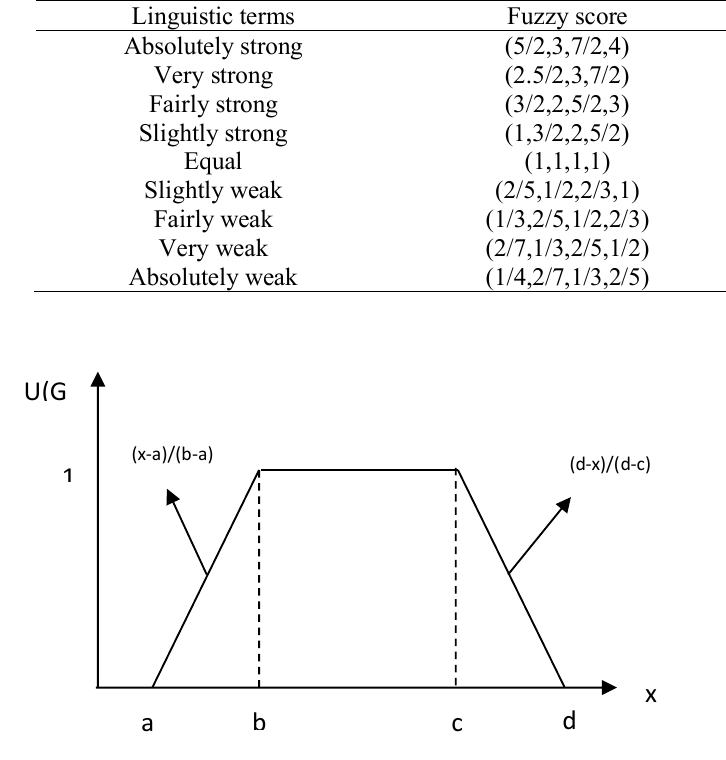
Figure 4. Membership function of triangular fuzzy number (Ahmadipari et al.